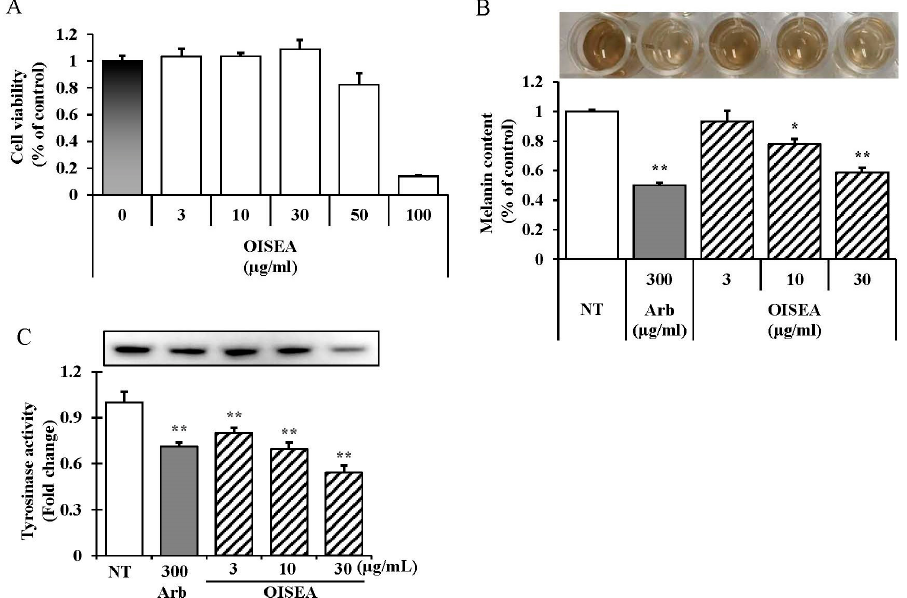
Figure 3. Effects of OISEA on melanogenesis in melan-a cells. Cells were cultured with OISEA (3–10 µg/mL) for 3 days. ( A ) Cytotoxicities, ( B ) melanin contents, and ( C ) tyrosinase activities were measured as described in Materials and Methods. Experiments were performed in triplicate, and results are presented as means ± SD. * p < 0.05, ** p < 0.01, NT: No treatment; Arb: Arbutin.